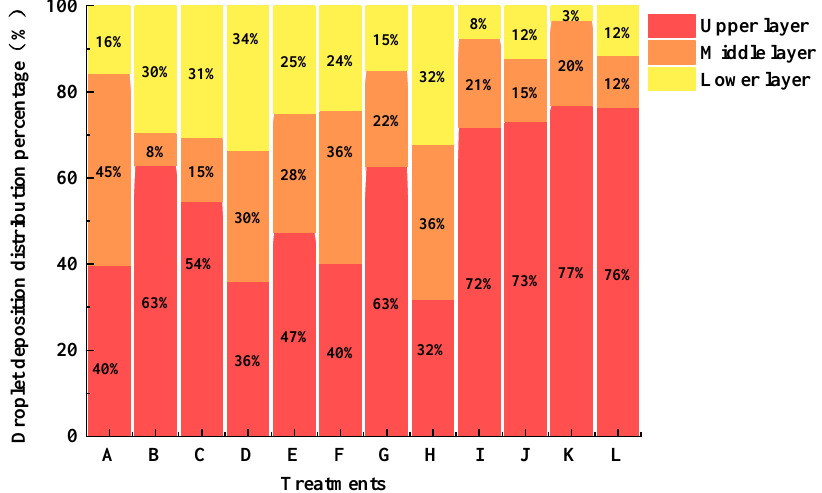
Figure 10. Distribution of droplet deposition in different canopy layers of rice under different experimental treatments.